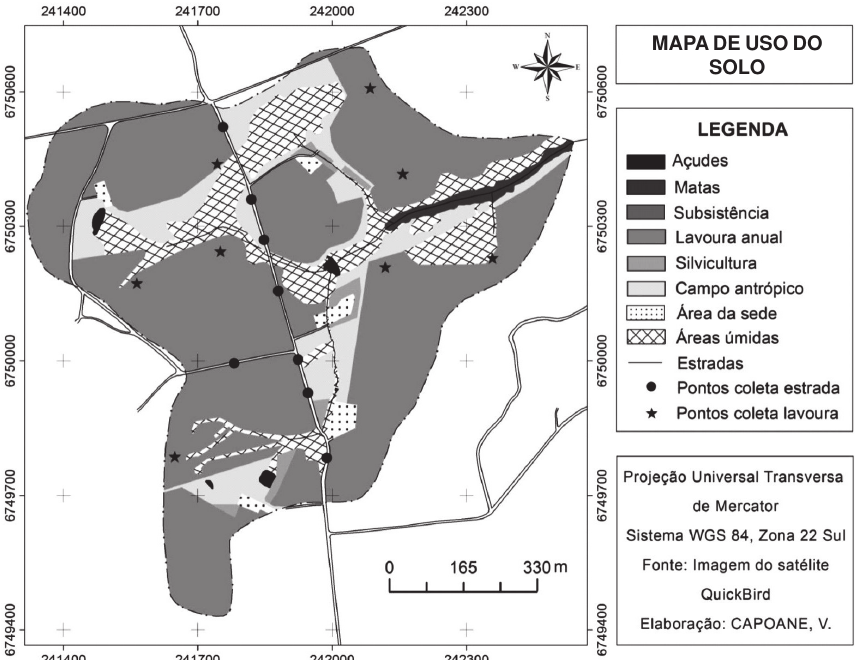
Figura 1. Mapa de uso do solo na bacia hidrográfica do Assentamento Alvorada, Júlio de Castilhos, Rio Grande do